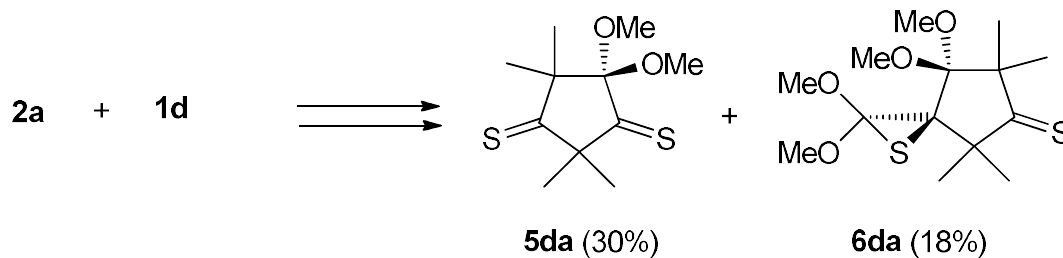
Scheme 2. Products obtained in reactions of 2,2,4,4-tetramethylcyclobutane-1,3-dithione ( 2a ) with nucleophilic dimethoxycarbene ( 1d ).